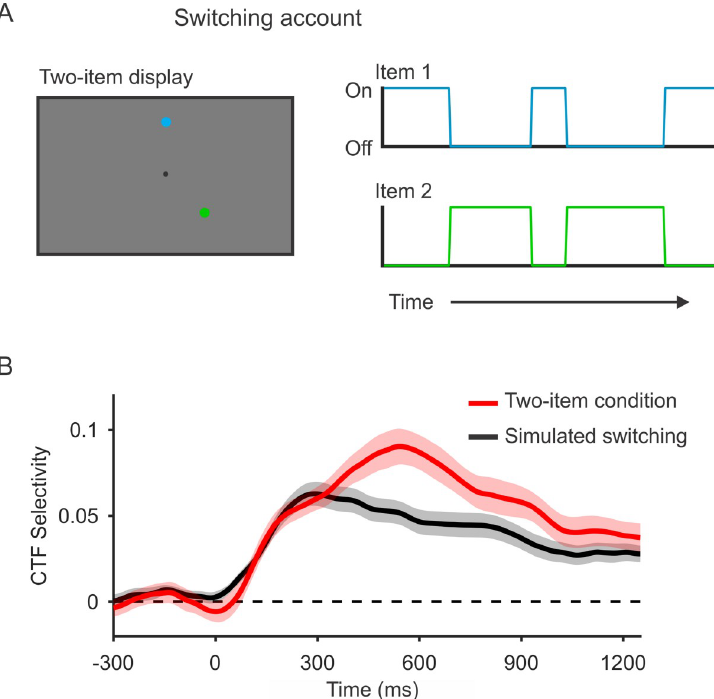
Fig 5. Alpha-band activity concurrently represents 2 spatial positions. (A) If only 1 item can be represented by alpha-band activity at a time, then in the two-item condition, the items might alternate between an active and an activity-silent state such that only 1 item is actively represented at once. We used data from the single-item condition to simulate the expected CTF based on this switching account. This account holds that each item is represented 50% of the time (on average). Thus, we simulated switching between items by randomizing the position labels for 50% of trials for the one-item condition. (B) Spatial selectivity of alpha-band CTFs across time (measured as CTF slope) for the two- item condition (red) and for simulated switching (black). CTF selectivity was reliably higher during the two-item condition (red) than for simulated switching (black). The shaded error bars reflect ± 1 SEM across observers. Data are available at https://osf.io/47cmn/. CTF, channel-tuning function.